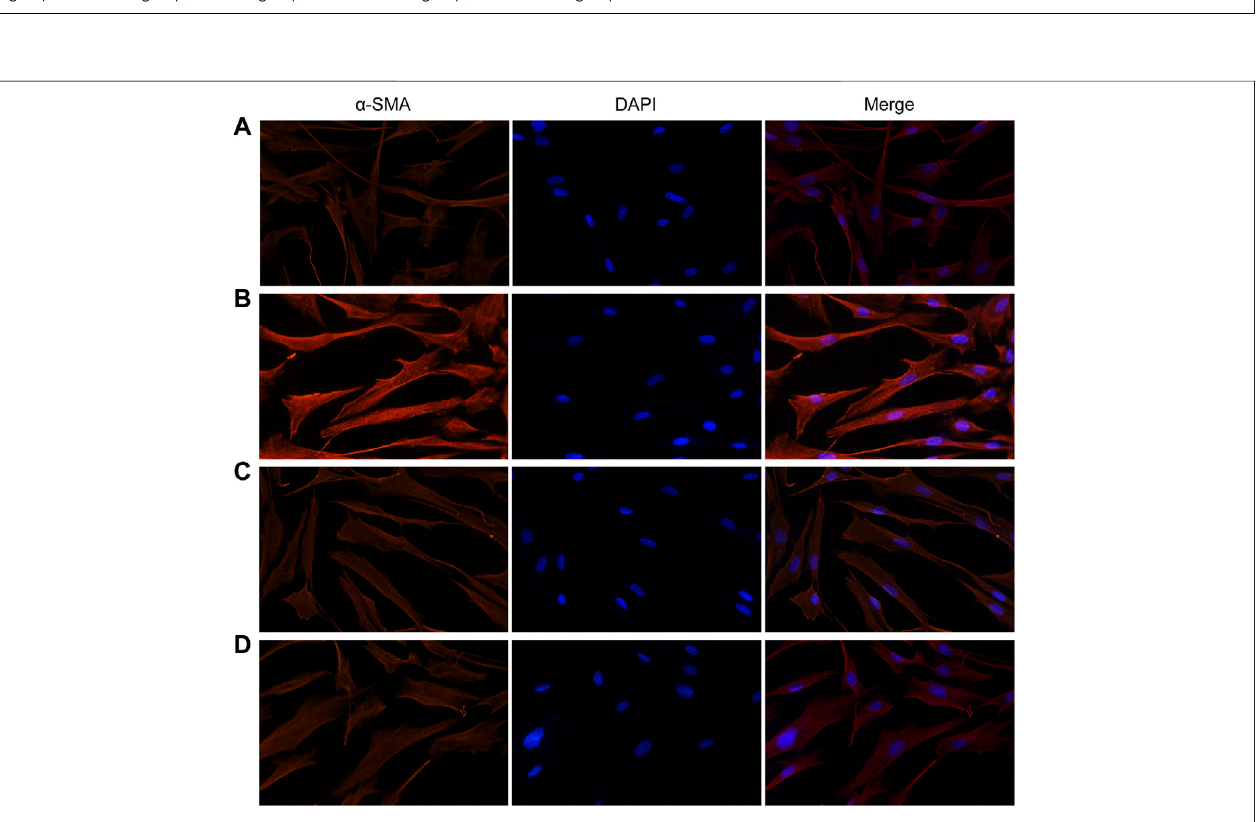
FIGURE 5 | Expression of α -SMA induced by VCR in HELFs (original magni fi cation, ×400). HELFs were cultured with VCR (1.4 μ g/ml) for 24 h. Immunocytochemical analysis showed that α -SMA expression was markedly increased in the VCR group compared with the control group, but was decreased in the two inhibitor groups. Red represents α -SMA; blue represents nuclei. (A) : control group, (B) : VCR group, (C) : SB203580 group, (D) : PD98059 group.